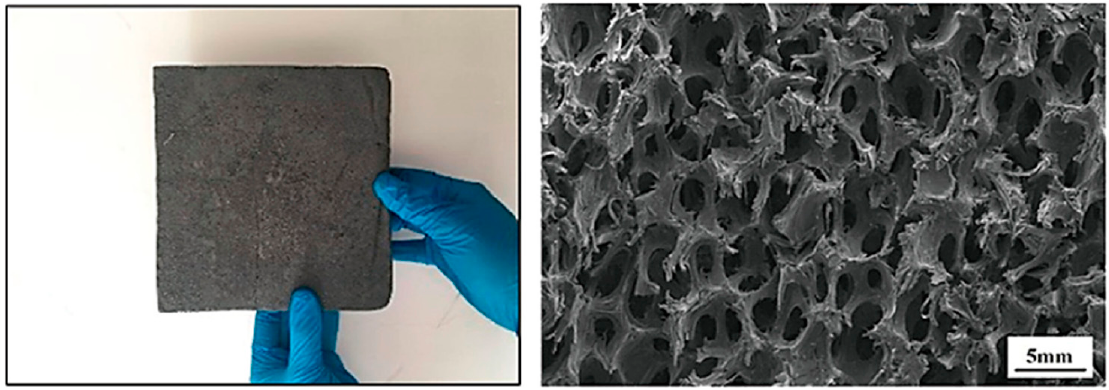
Figure 4. Graphene-based foam utilized for PCM composite studies [51].